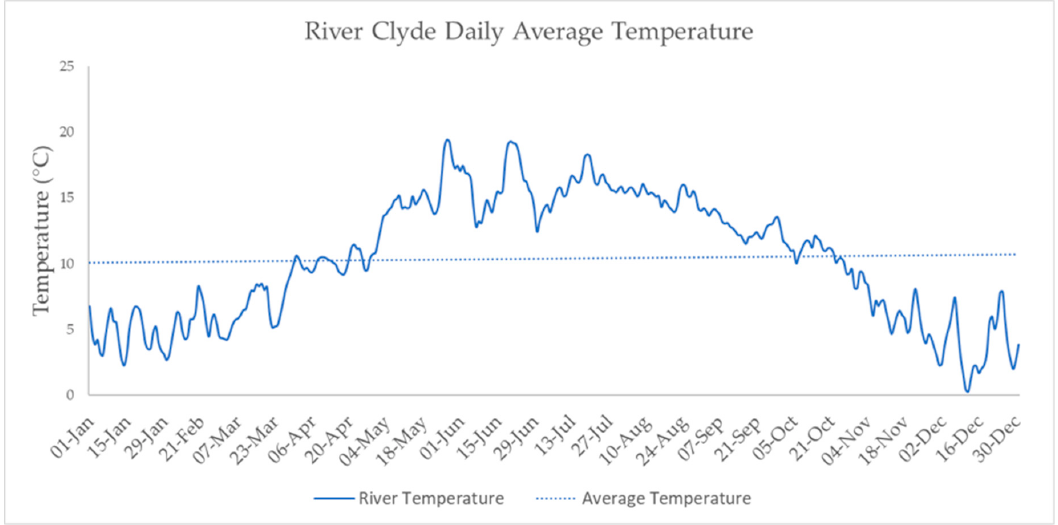
Figure 7. Average daily River Clyde water temperature at Daldowie for 2017.